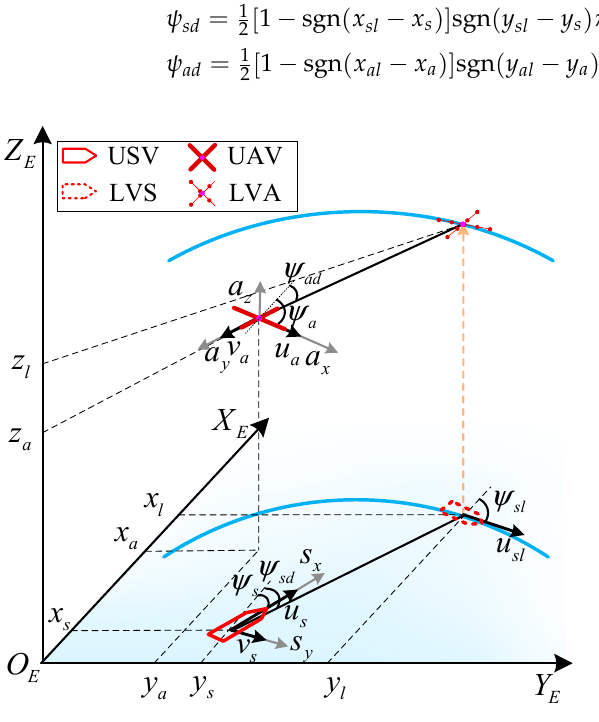
Figure 2. The LVS-LVA guidance framework of the USV-UAV system.